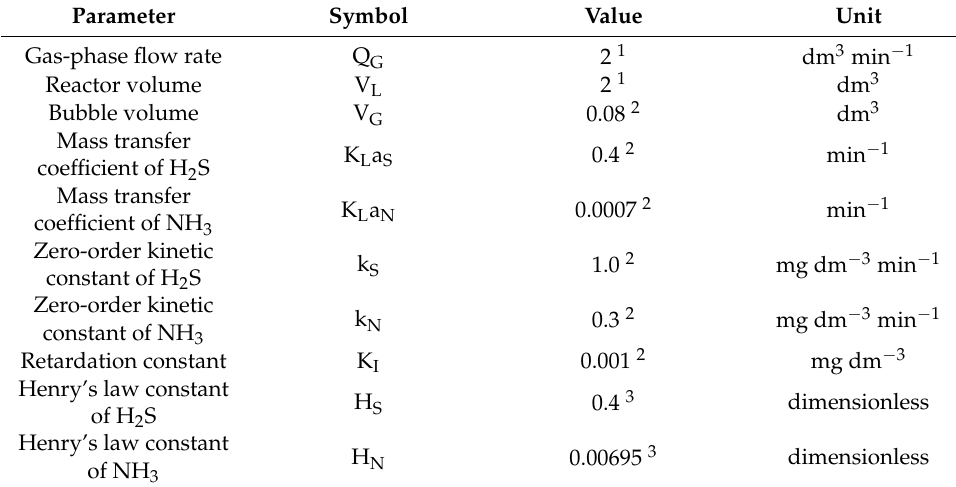
Table 1. Model parameters used in this